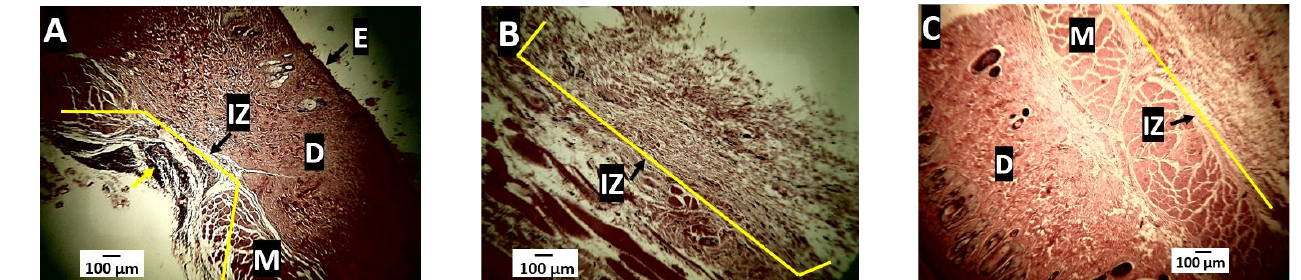
Figure 16. Porcine collagen samples implanted at 30, 60, and 90 days. ( A ): 30 days, Hematoxylin- Eosin technique, 4×. ( B ): 60 days, Hematoxylin-Eosin technique, 4×. ( C ): 90 days, hematoxylin-eosin technique, 4×. E: epidermis. D: dermis. M: muscle. IZ: implantation